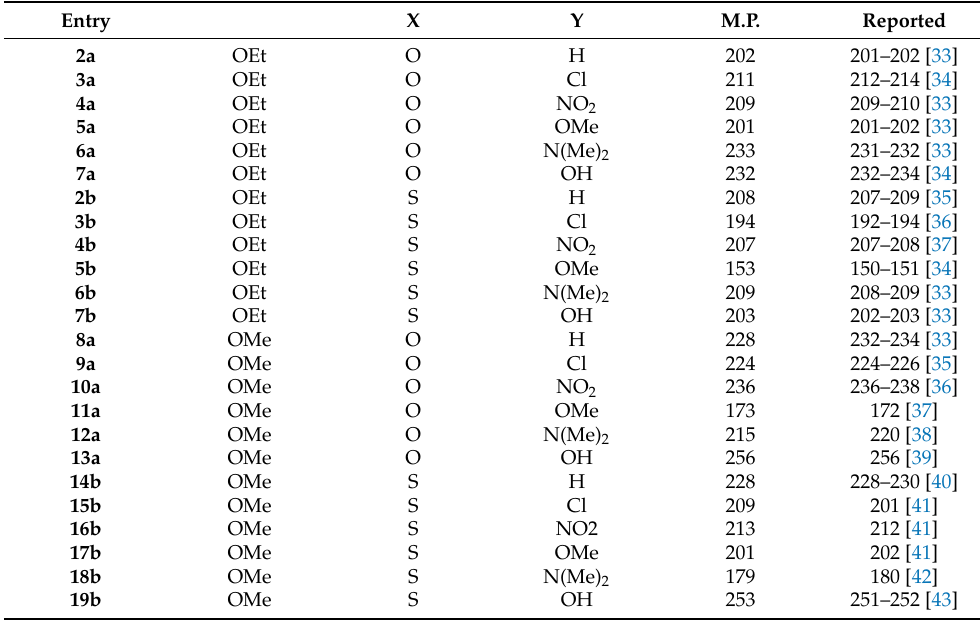
Table 2. Synthesis of 3,4-dihydropyrimidine-2(1 H